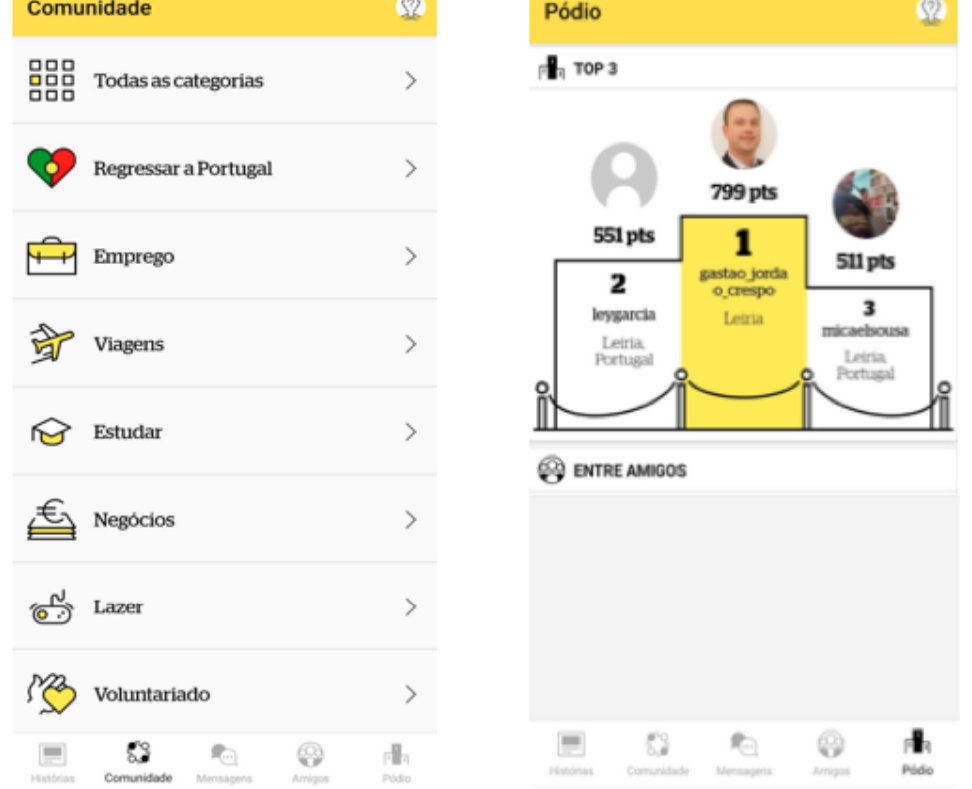
Figure 2. Guests ’ posts and spaces to foster public participation in the app Repórter no Mundo. Figure 2. Guests’ posts and spaces to foster public participation in the app Rep ó rter no Mundo